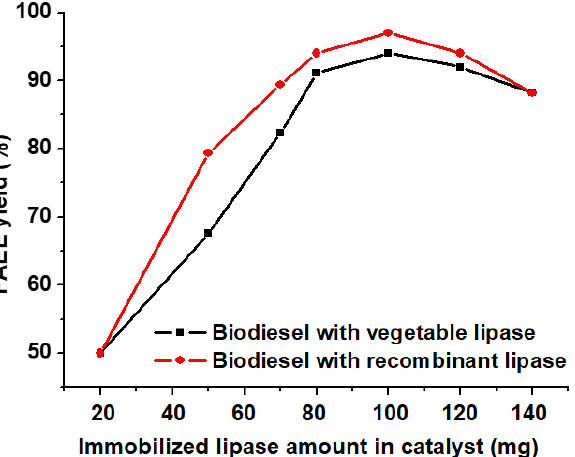
Figure 6. Effect of the immobilized lipase amount in microcapsules on FAEE yield. Experimental parameters: Jatropha oil mass: 10 g; ethanol to oil mass ratio: 10; water content: 9.1 wt%; reaction temperature: 35 °C; reaction time: 24 h, and pH value: 7.5.